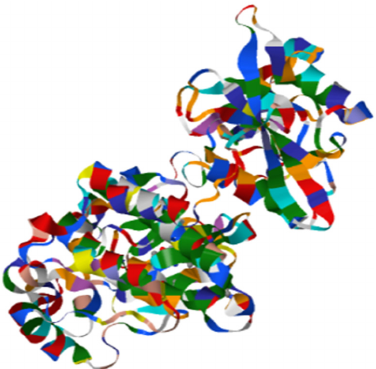
Figure 4. PID is a Src kinase complex-binding crystal of 2H8H.